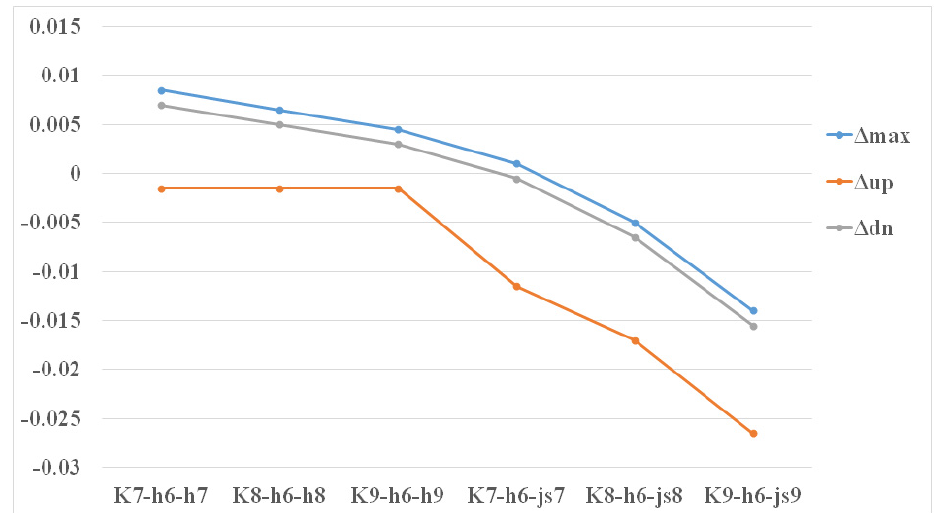
Figure 7. Change of the clearances in the engagement when manufacturing the external profile disk by the K fit.